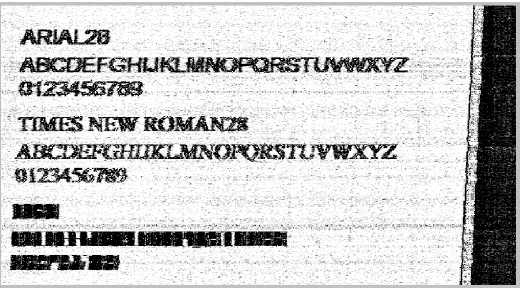
Figure 18. Font 28: Arial, TNR and secure asymmetrical—upper case.